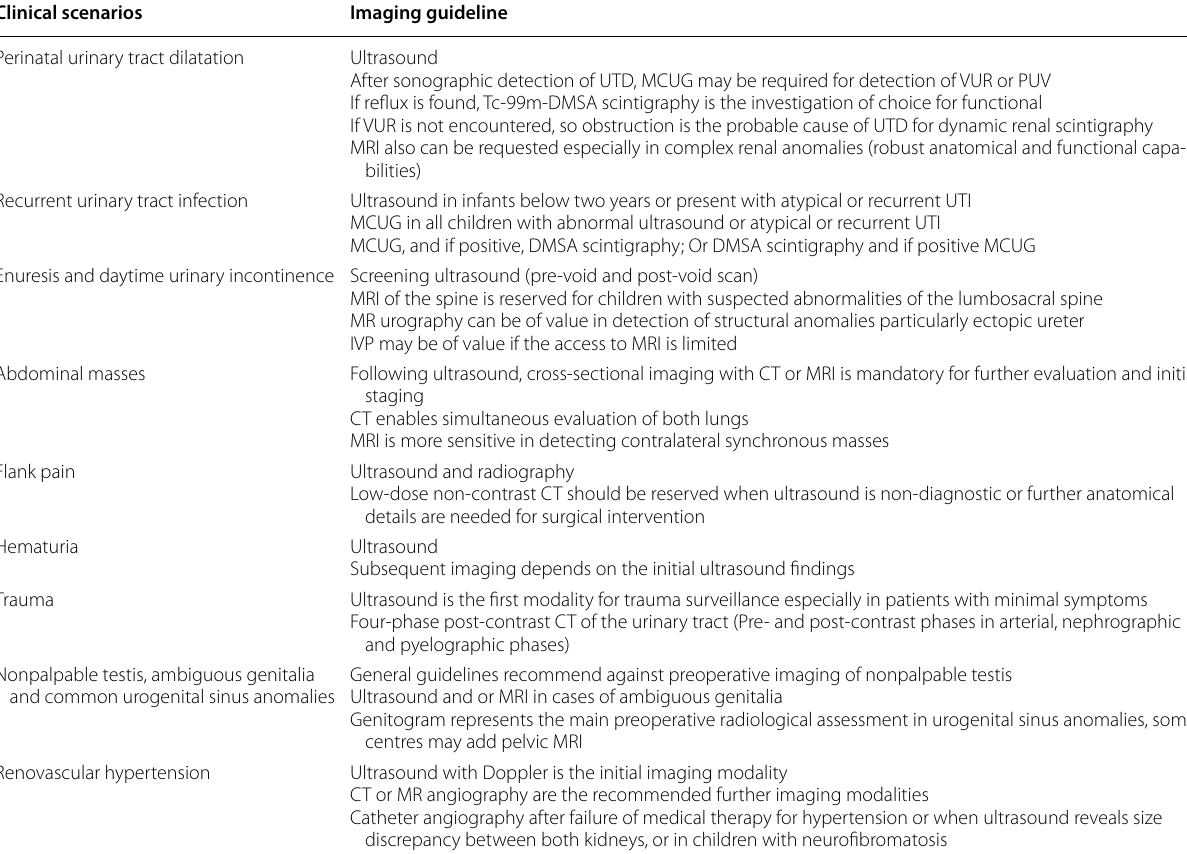
Table 1 Different clinical scenarios and imaging guideline Clinical scenarios Imaging guideline Perinatal urinary tract